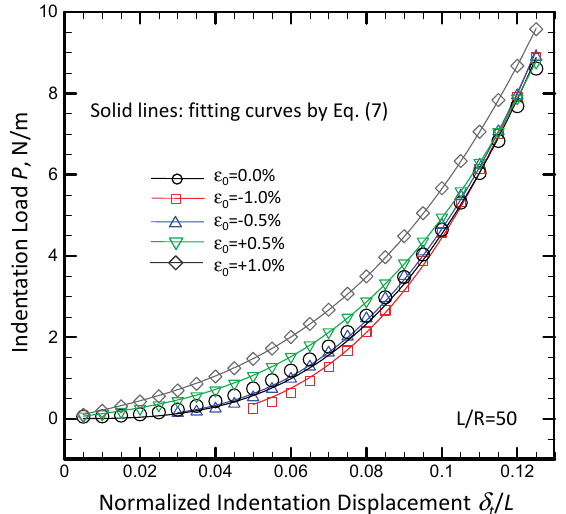
relationship of monolayer graphene determined from free standing Figure 14. The P - δ t indentation. P is the indentation load; δ is the indenter tip displacement, normalized by the t graphene length L